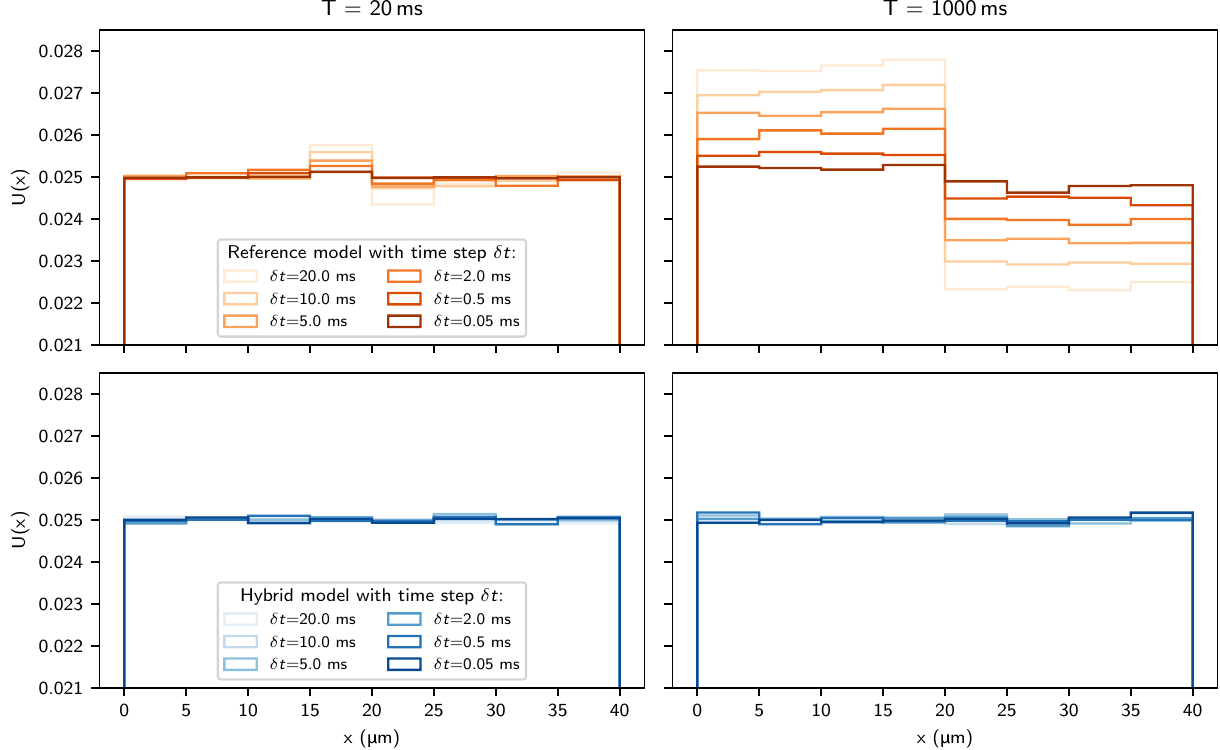
Figure 3. Histograms of walker positions after random walk simulations of the steady state. Initial positions were sampled from a uniform distribution to seed walkers with a constant density throughout the domain. We 10 6 . We applied the reference membrane model (top) described in have performed the simulations with N p = 0.05 µ m / ms , and the new hybrid model (bottom) from Eq. (6). Simulations were Eq. (5), with permeability κ = performed with varying step sizes δ t for a short and a long simulation time T . We consider D L 20 µ m 2.5 µ m 2 / ms and L D R = =